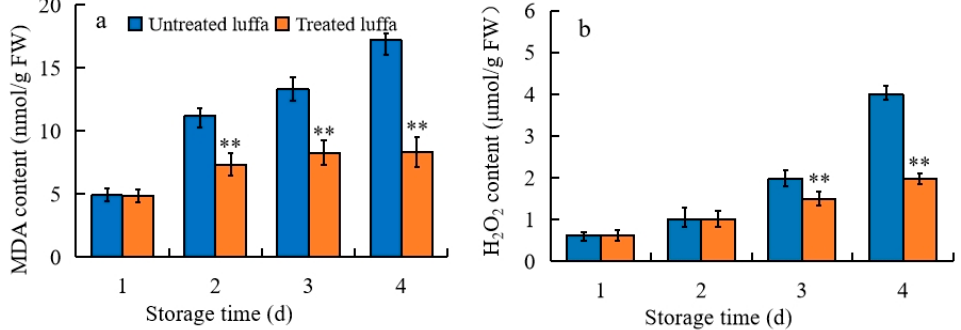
Figure 2. Effect of CaCl 2 treatment on ( a ) MDA and ( b ) H 2 O 2 contents in fresh-cut luffa. Each value is presented as mean ± SE ( n = 3). ** represent extremely significant differences ( p < 0.05). MDA, malondialdehyde; H 2 O 2 , hydrogen